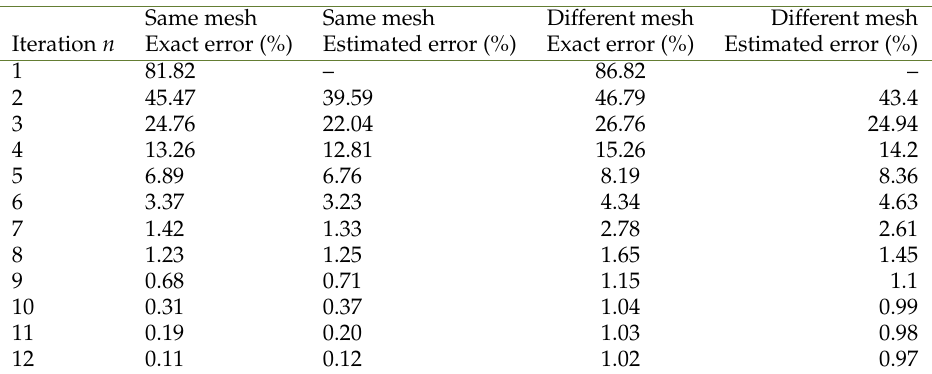
Table 1. The exact and estimated errors at the left end of thin